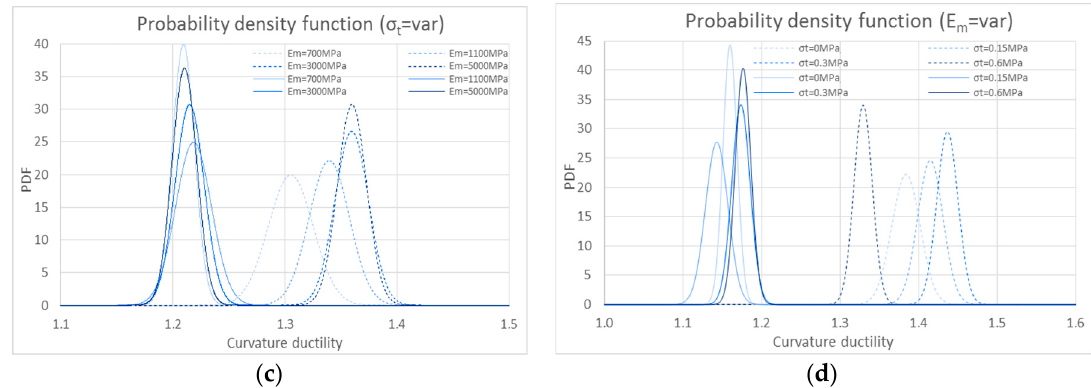
Figure 16. Probability density functions: ( a , c ) curvature ductility value to change the tensile strength of masonry; ( b , d ) curvature ductility value to change the Young’s modulus, for the two stress strain relationships for hemp fiber—tri-linear (solid lines) and bi-linear (dotted lines). ( a , b ) on weak masonry ( σ 0 = 1 MPa) and ( c , d ) with σ 0 = 8 MPa.